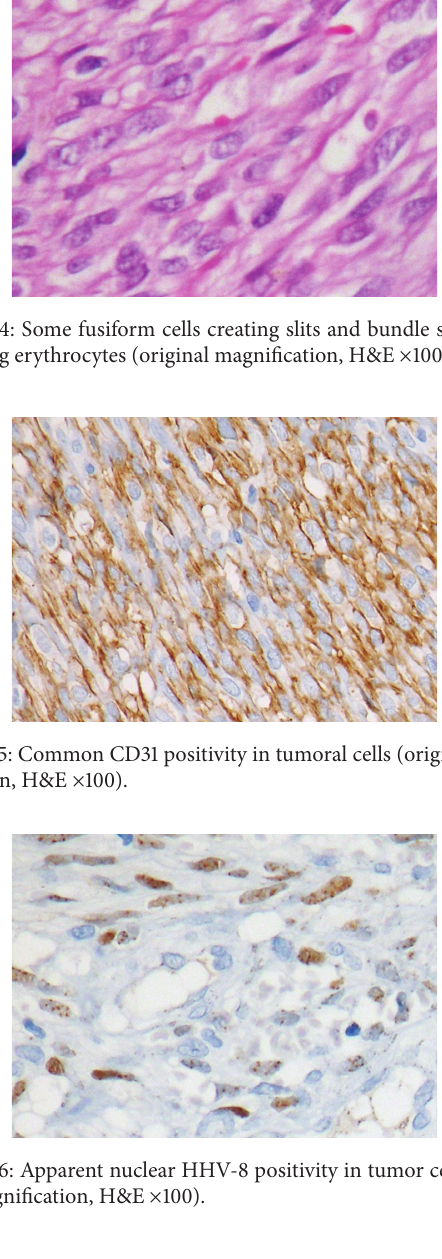
Figure 3: Tumoral mass consisting of fusiform cells under the sur- face epithelium (original magnification, H&E × 40).